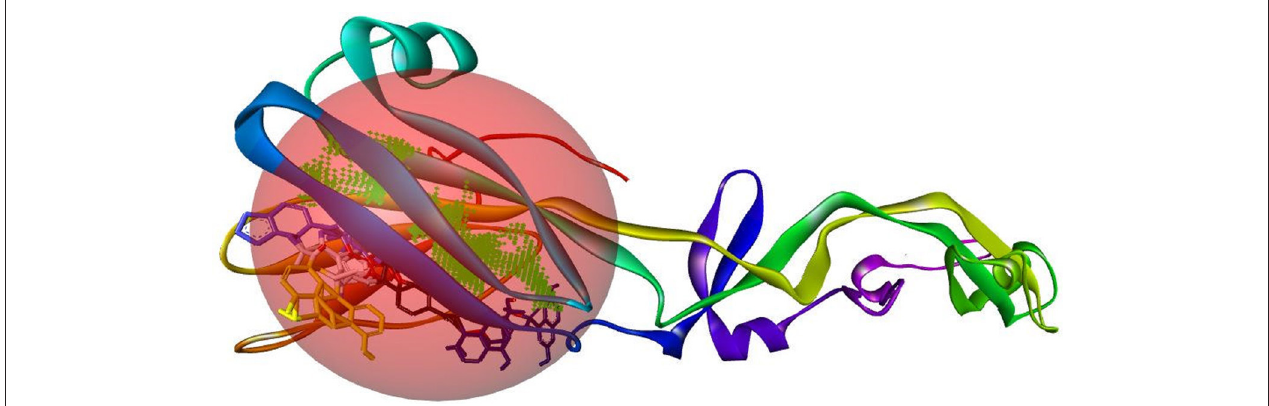
FIGURE 10 | Amino acid interaction with inhibitors. (A) AP30451, (B) Designed molecule 1, (C) design molecule 2, (D) Designed molecule 3, (E) Designed molecule 4.